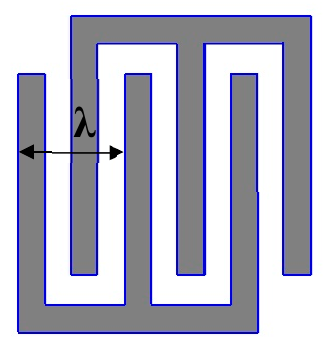
Figure 4. Inter-digital transducer.